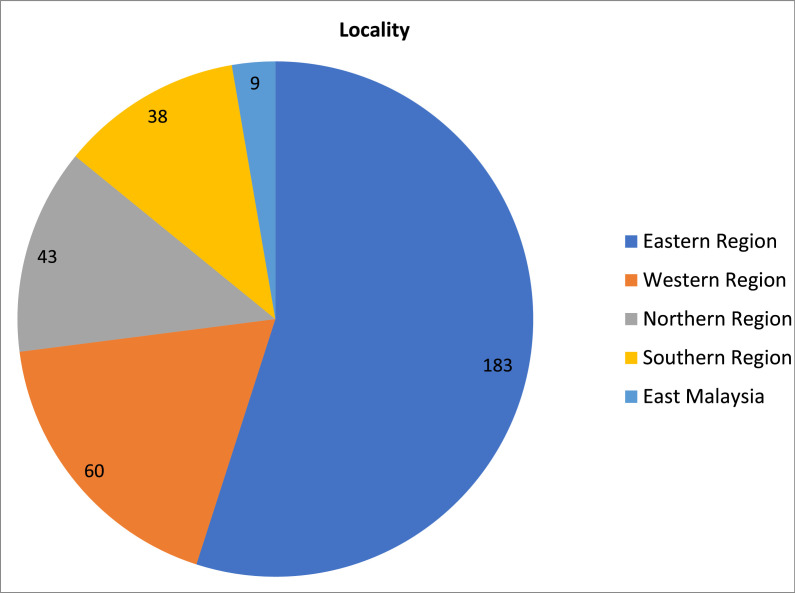
Parent's locality.